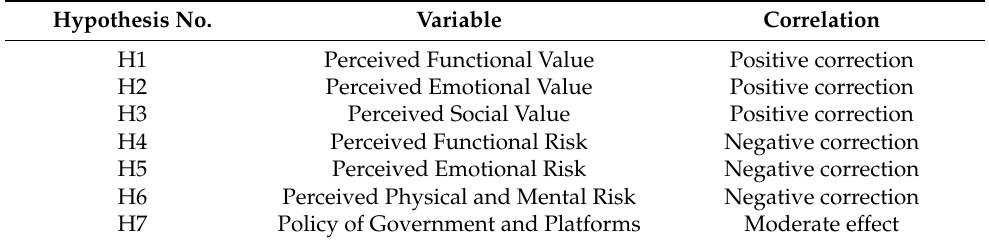
Table 3. Hypotheses for the correlation between variables and purchase